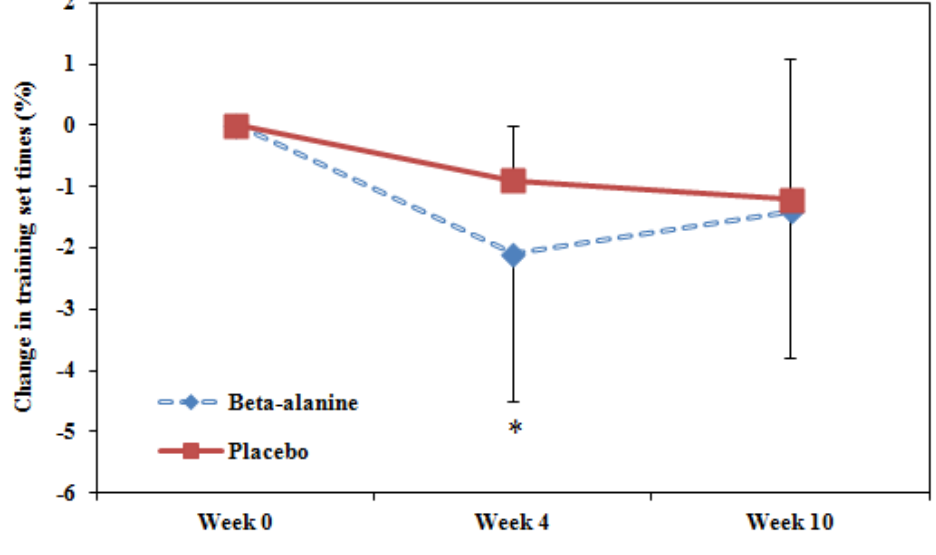
Figure 3. Beta-alanine supplementation improved training set times at 4 weeks but not 10 weeks. Data are mean ± SD. * indicates a substantial difference between BA and